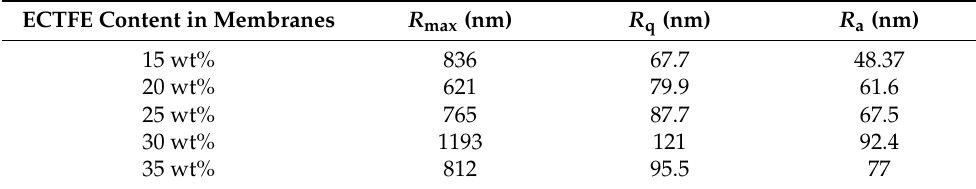
Figure 4. Effect of ECTFE concentrations on water contact angle ( a ) and liquid entry pressure ( b ) of the ECTFE membranes. Table 6. Surface roughness parameters of ECTFE porous membranes prepared with different poly- mer